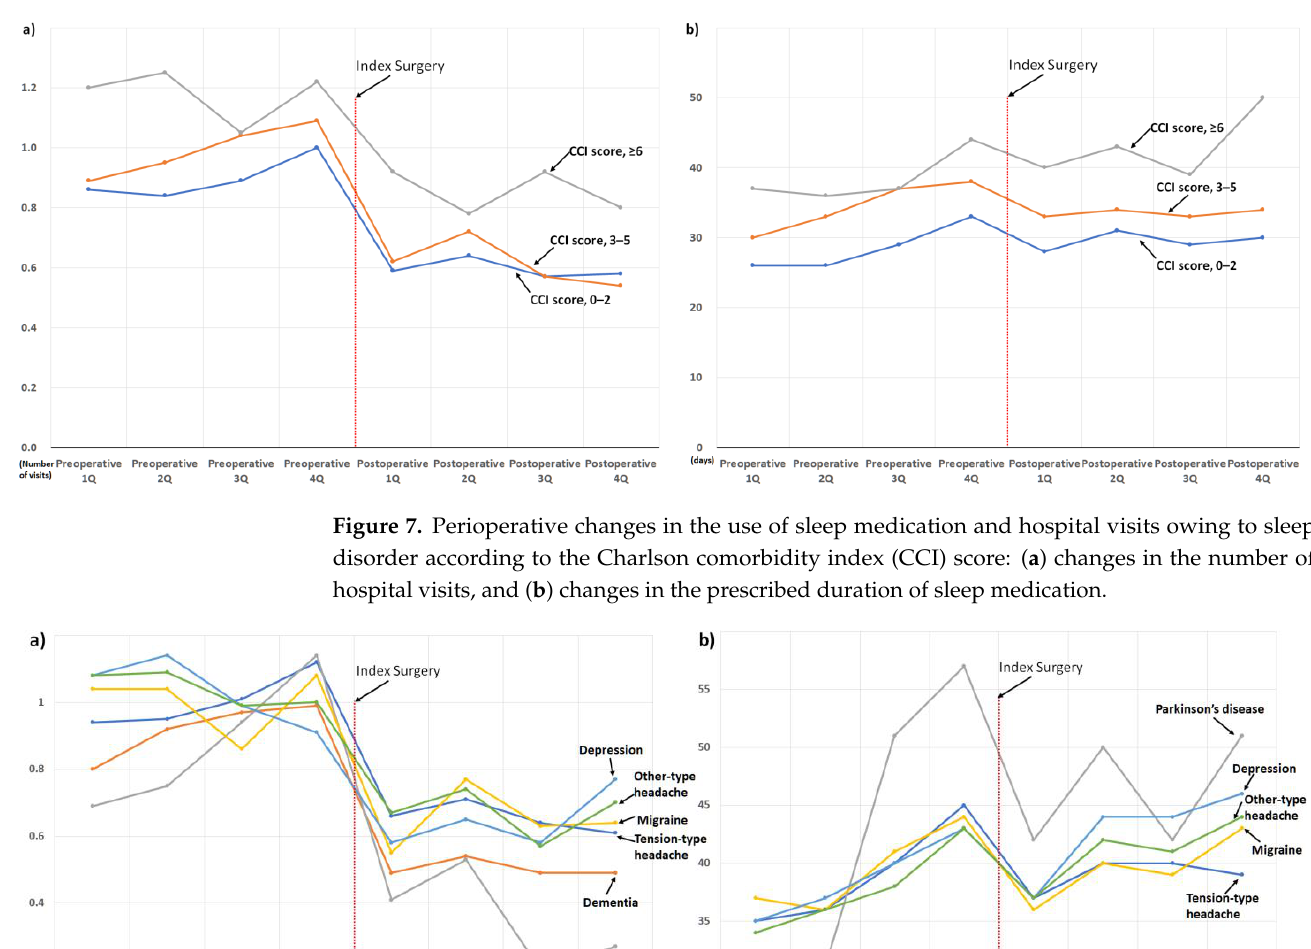
Figure 6. Perioperative changes in the use of sleep medication and hospital visits owing to sleep disorder according to the spinal regions: ( a ) changes in the number of hospital visits, and ( b ) changes in the prescribed duration of sleep medication.